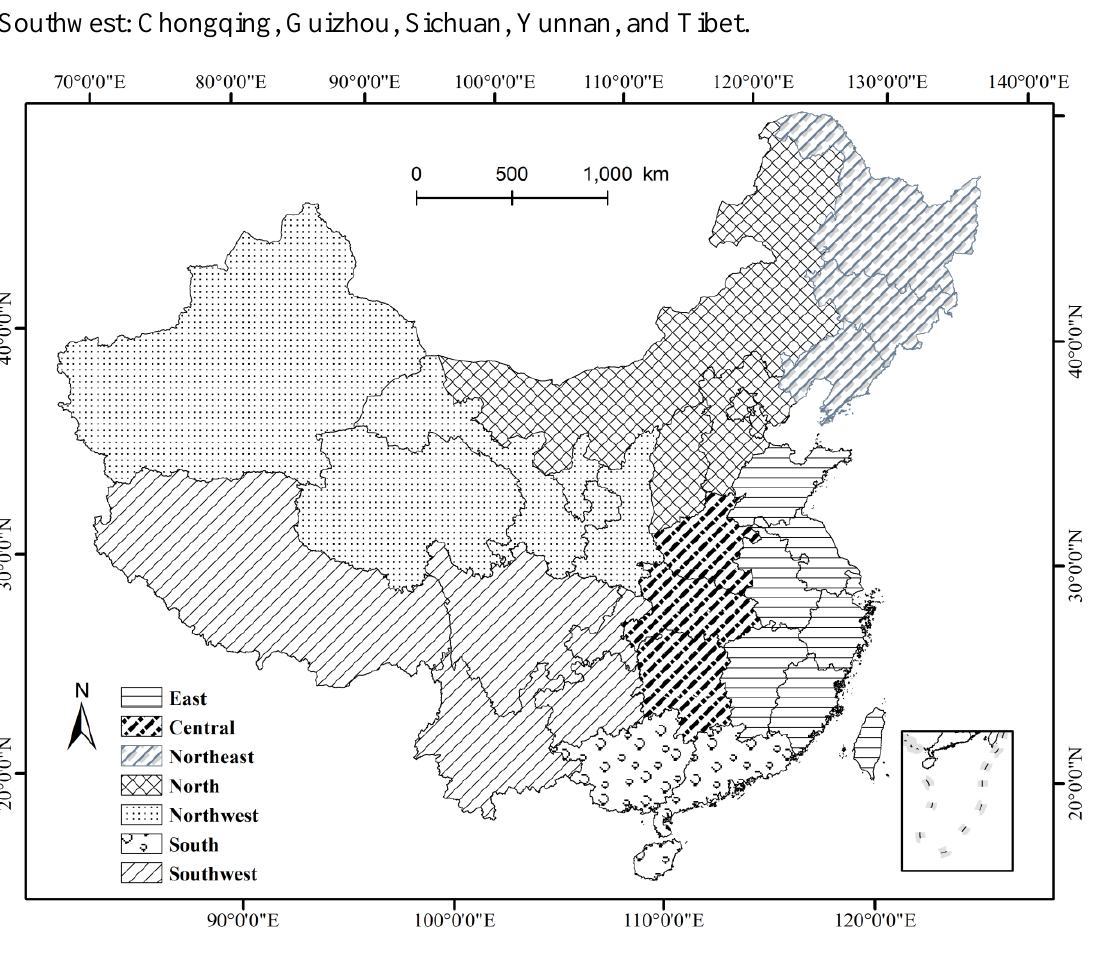
Figure 6. Geographical locations of regions and provinces in